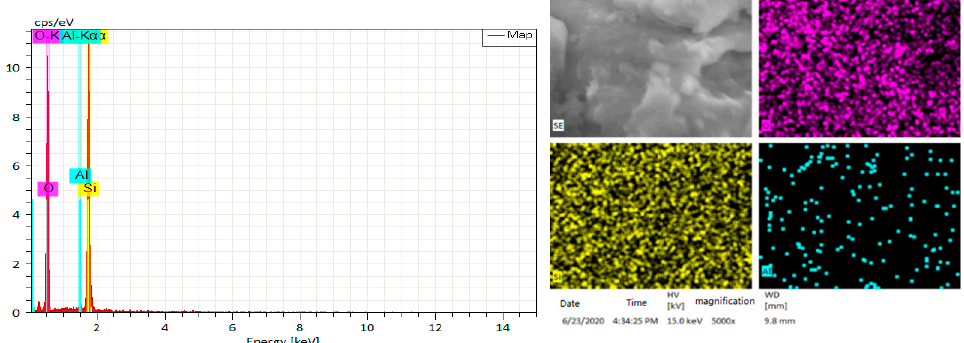
Figure 5. The energy dispersive spectroscopy (EDS) pattern of the Al-KT-40 sample-corresponding electron mapping.